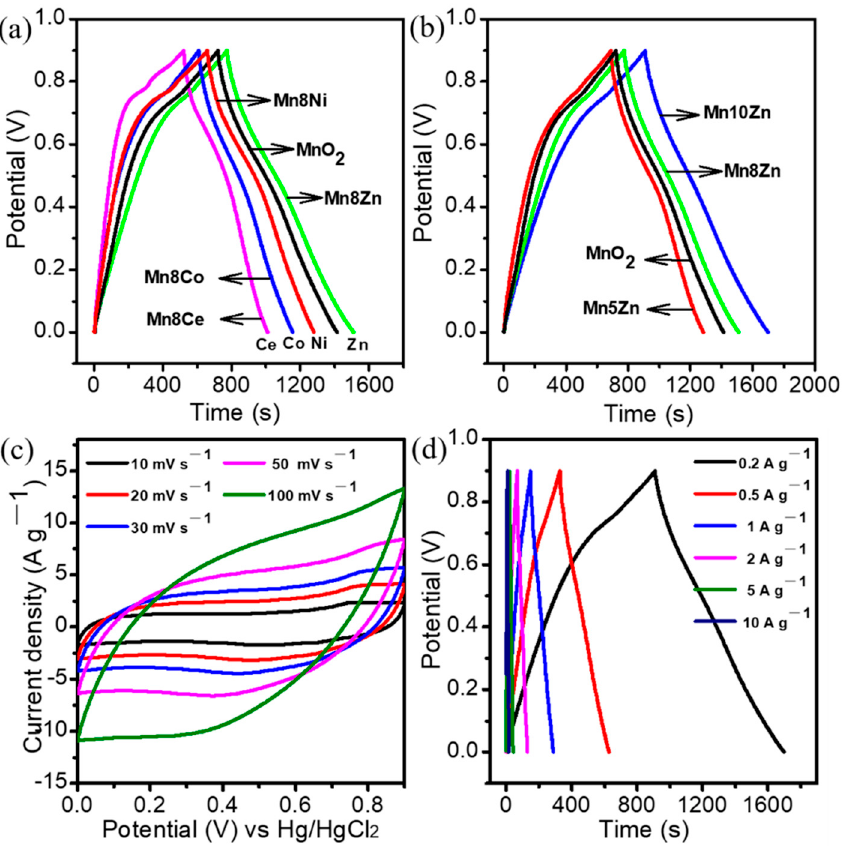
Figure 4. ( a , b ) GCD profiles of the layered MO x - δ -MnO 2 (M = Co, Ni, Zn, Ce) materials; ( c , d ) CV and GCD patterns of